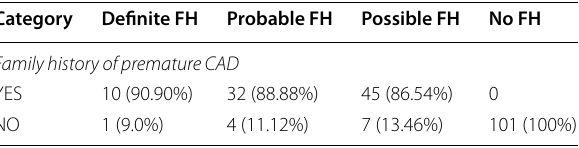
Table 6 Frequency of patients having a positive family history of premature CAD